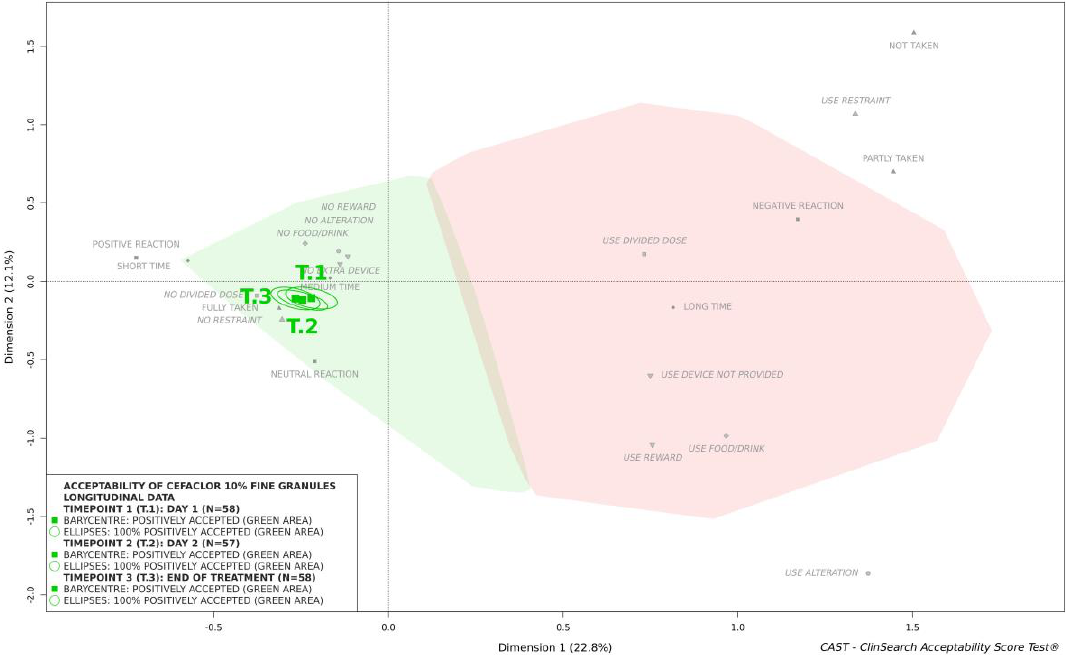
Figure 2. Acceptability over time of cefaclor 10% fine granules.